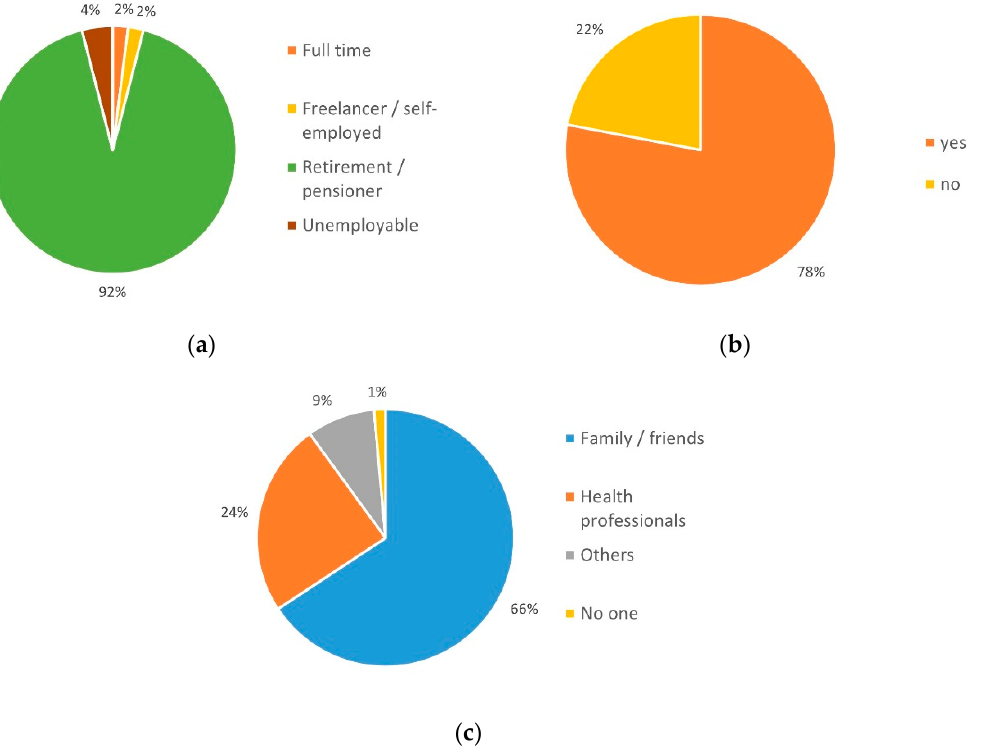
Figure 3 . Situation at home: ( a ) job situation, ( b ) support at home, ( c ) primary care giver . The questionnaire revealed that most patients with a VAD system were no longer able to pursue regular employment—96% ( n = 48) of the patients were without permanent employment and receiving pension or social welfare benefits (Figure